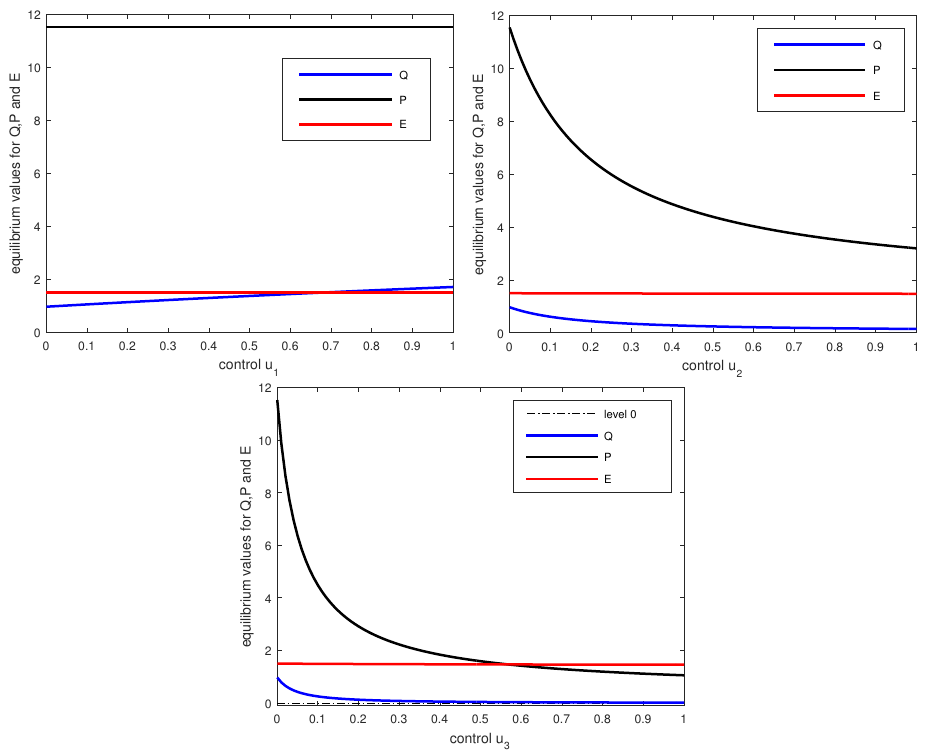
Figure 4. The values of the positive equilibrium point ( Q ∗ , P ∗ , E ∗ ) as the values for a single control are varied from 0 to 1. The parameter values used in the computations are given in Tables 1 and